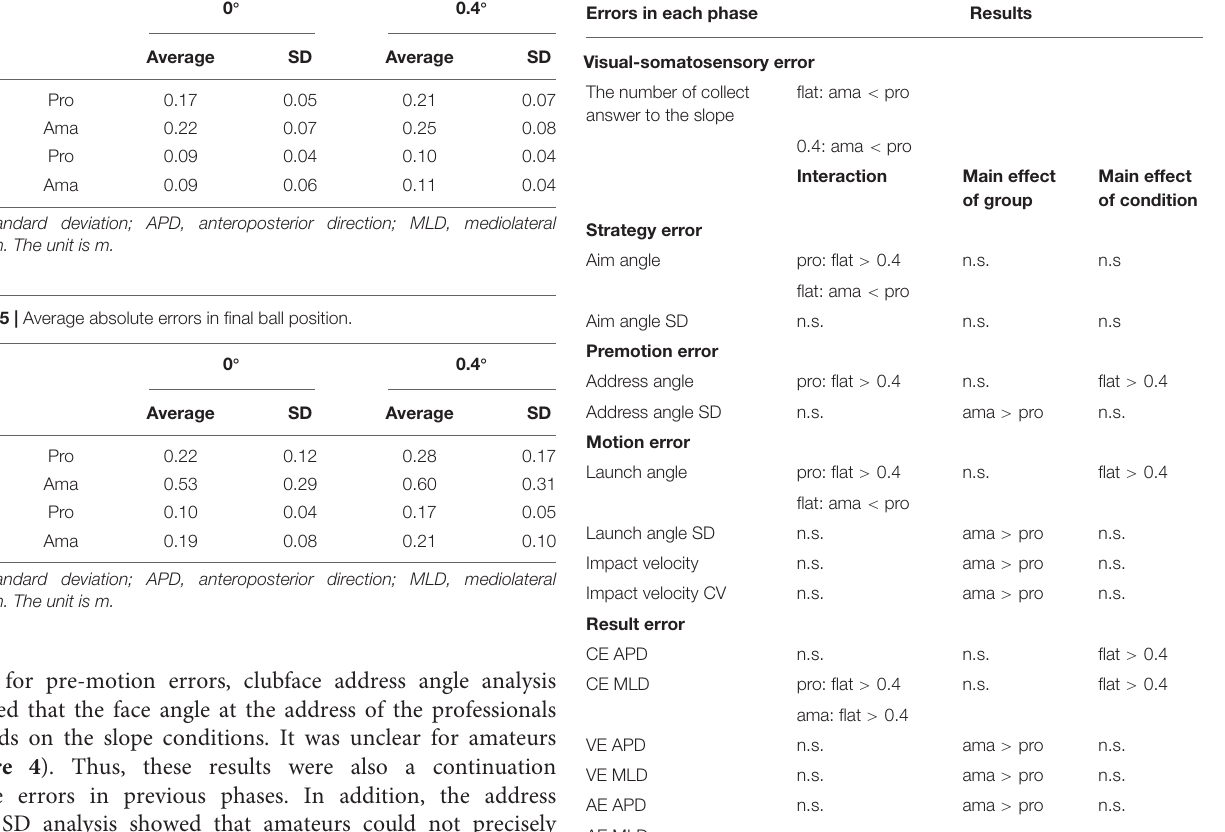
TABLE 6 | Results list of this